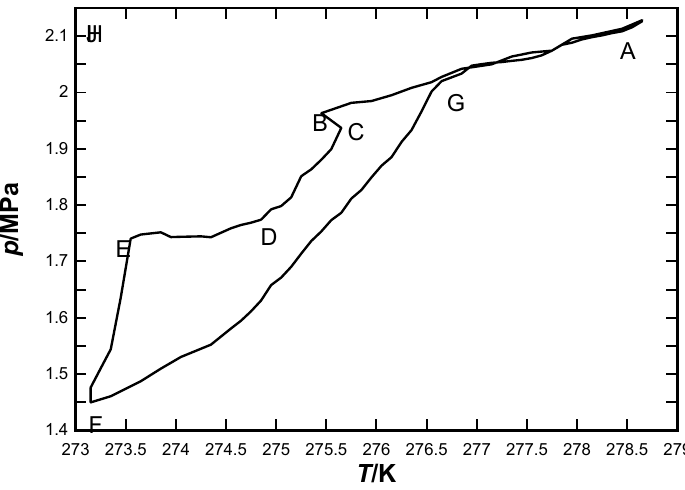
Figure 4. Typical p-T curves for CO size distribution.